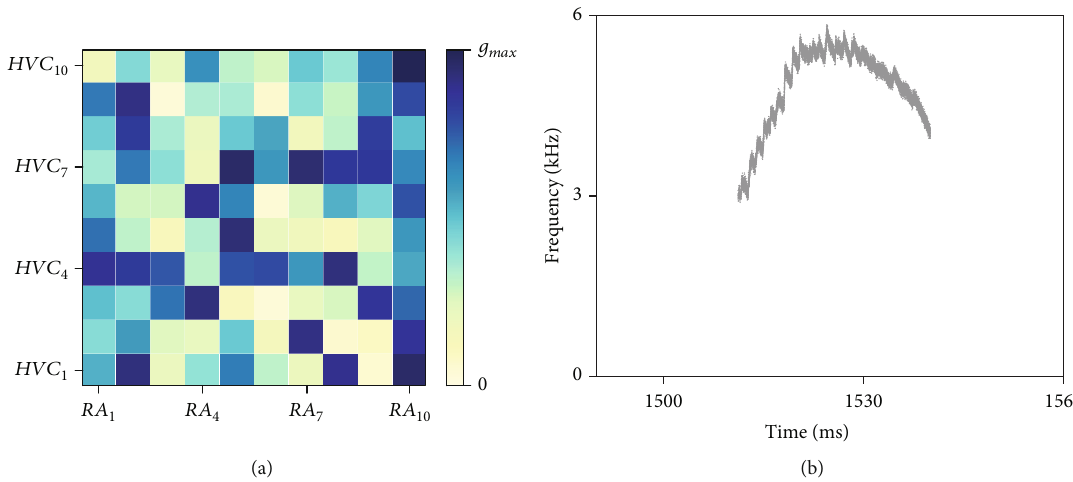
Figure 4: Intensity distribution of the synaptic conductance matrix and the corresponding syllable produced. (a) A random synaptic conductance matrix g × Γ with each element from 0 to g . The square in ( i , j ) represents the synaptic conductance from HR − RP HR − RP HR − RP HVC to RA with its color depth indicating the intensity of conductance. (b) The corresponding syllables lasting 27.3ms with its basic i j frequency between 3 and